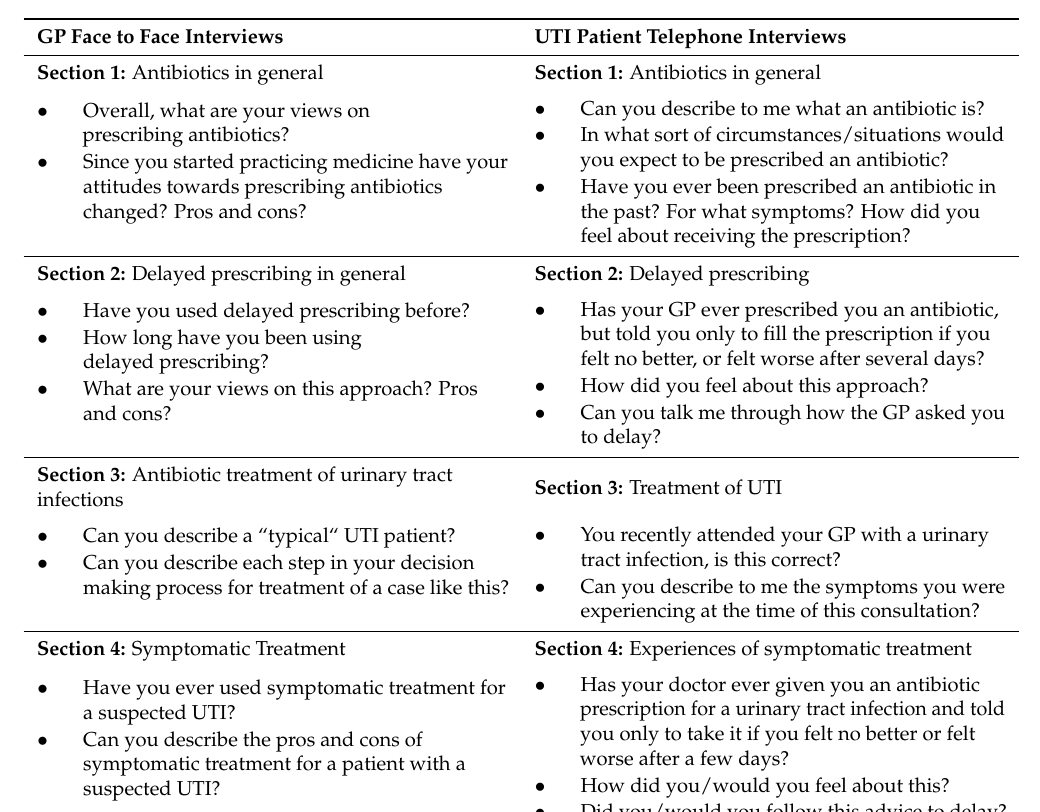
Table 1. Sample interview